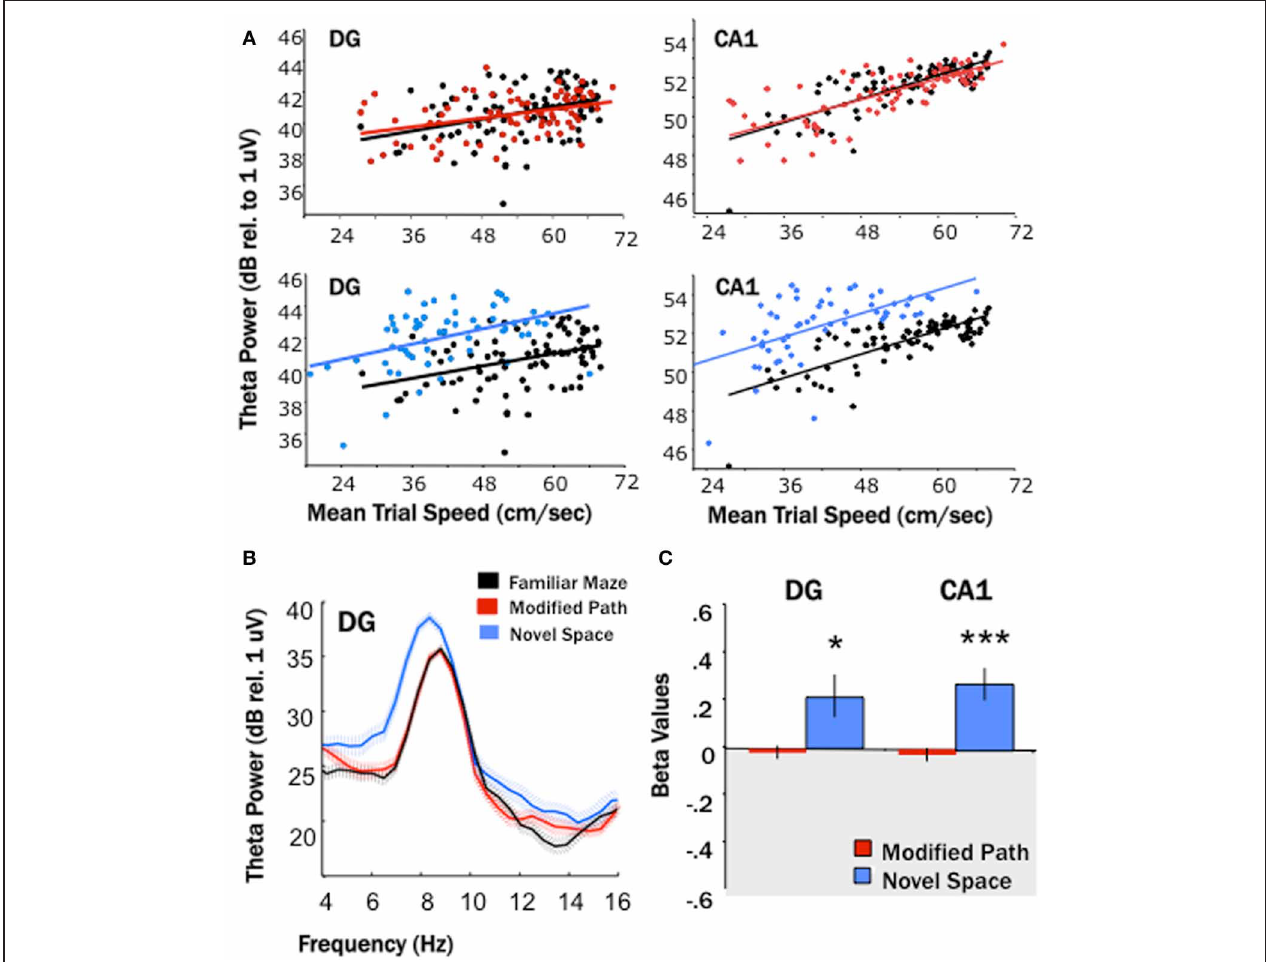
the familiar maze condition (black), on the modified path (red), and in a novel space (blue) in the DG. The hatched areas indicate the standard error of the mean across trials. Note the increase in average theta power and apparent decrease in theta frequency at the single DG site when not controlled for speed. (C) The standardized regression coefficient ( β -value, calculated for each channel from the area of theta power and average speed of each data segment using linear regression analysis) comparing changes in the modified path (red) and novel space (blue) from the familiar condition independent of speed. There was a significant increase in theta power at DG and CA1 sites independent of changes in locomotor speed in a novel spatial environment ( ∗ p < 0 . 05, ∗∗∗ p < 0 .